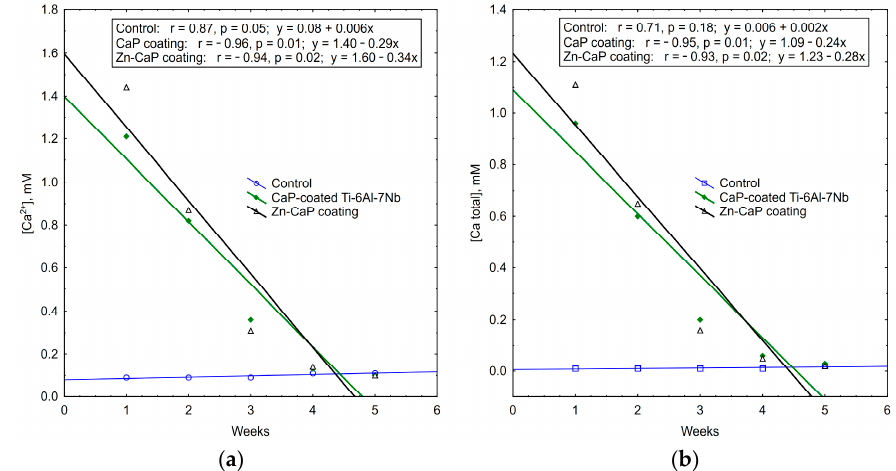
Figure 13. Regression lines of ( a ) Ca 2+ and ( b ) Ca total median concentrations in weekly extracts during 5-week immersion of Ti–6Al–7Nb substrates with different CaP coatings in 0.9% NaCl so- lution.